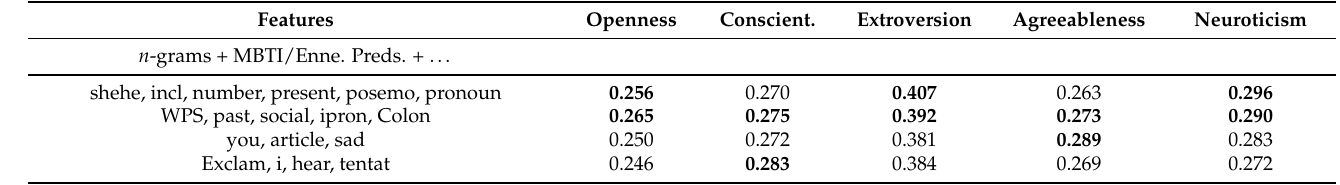
Table 13. Pearson correlation coefficient between the gold-standard Big Five labels and predictions achieved through using combinations of n -grams, MBTI/Enneagram predictions and selected LIWC dimensions for each of the MBTI traits (from top to bottom: (1) E-I , (2) S-N , (3) T-F and (4) J-P ). Features Openness Conscient. Extroversion Agreeableness